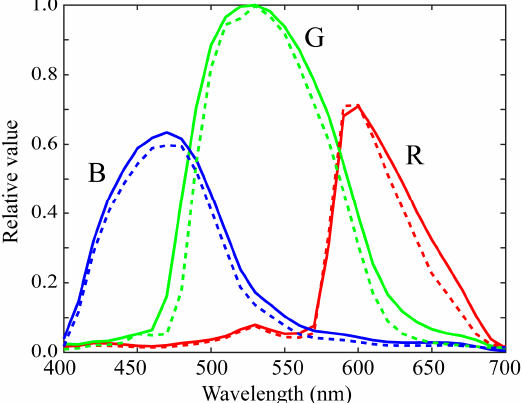
Figure 15. Estimated sensitivities of iPhone 8 at L = 1 and m = 10, where the bold curves represent the